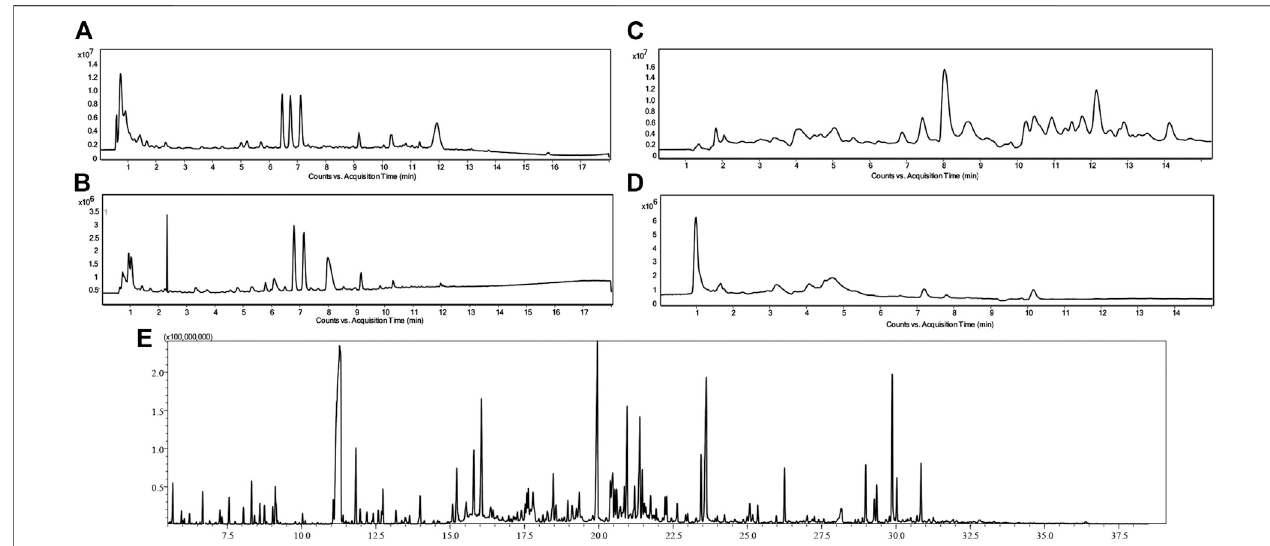
FIGURE 1 | Chromatograms of urine metabolic fi ngerprints measured by means of RP LC-TOF-MS in positive (A) and negative (B) ionization modes, HILIC LC- TOF-MS in both positive (C) and negative (D) ionization modes and GC-QQQ/MS (E) in a child with dysplastic kidneys.